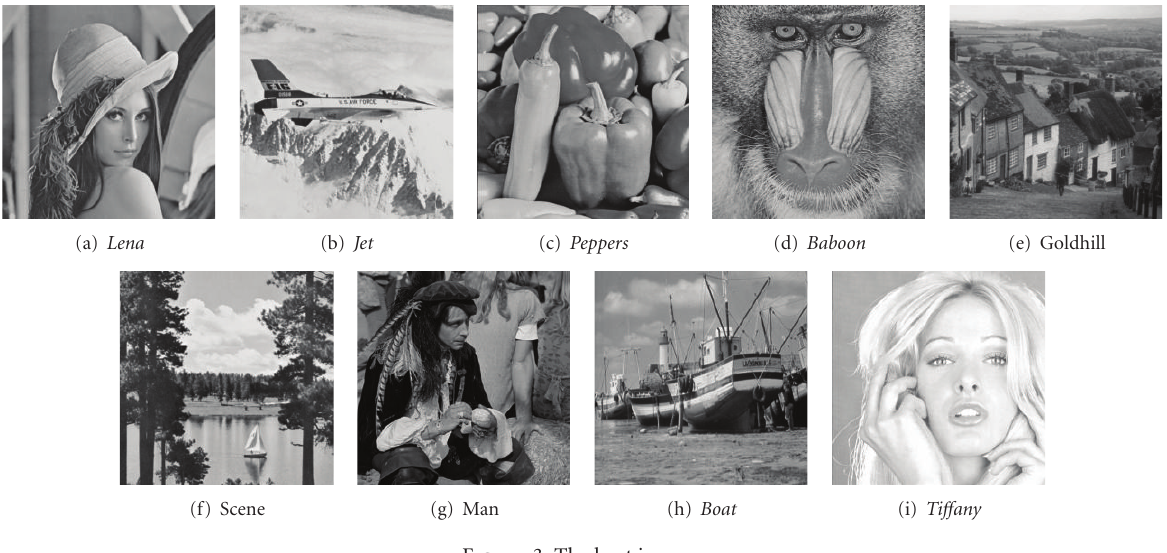
Figure 3: The host images.